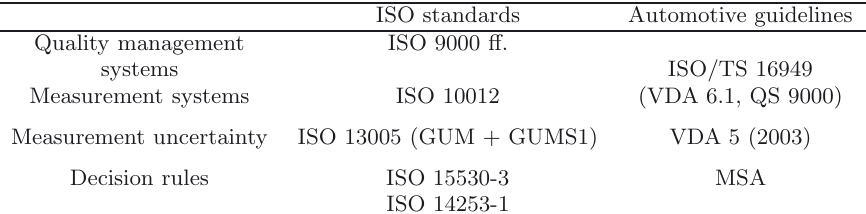
Table 1. Normative environment of conformance assessment.